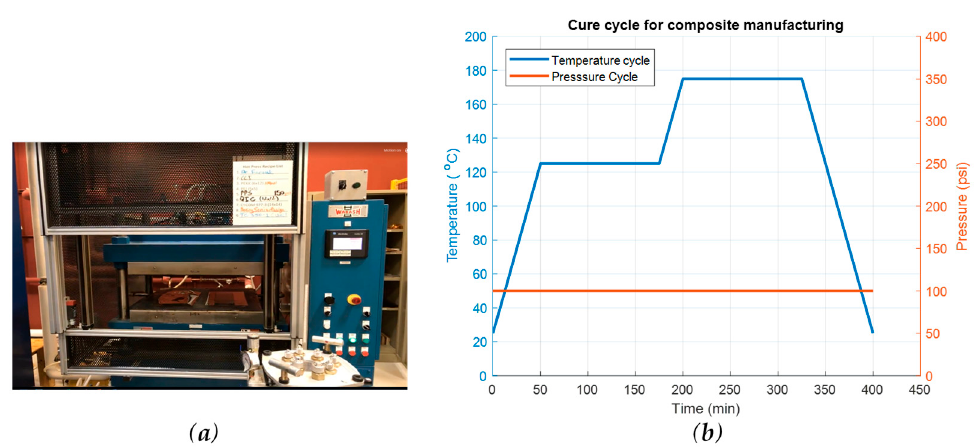
Figure 3. Experimental setup and curing cycle for the specimen manufacturing: ( a ) hot press machine; ( b ) curing cycle.